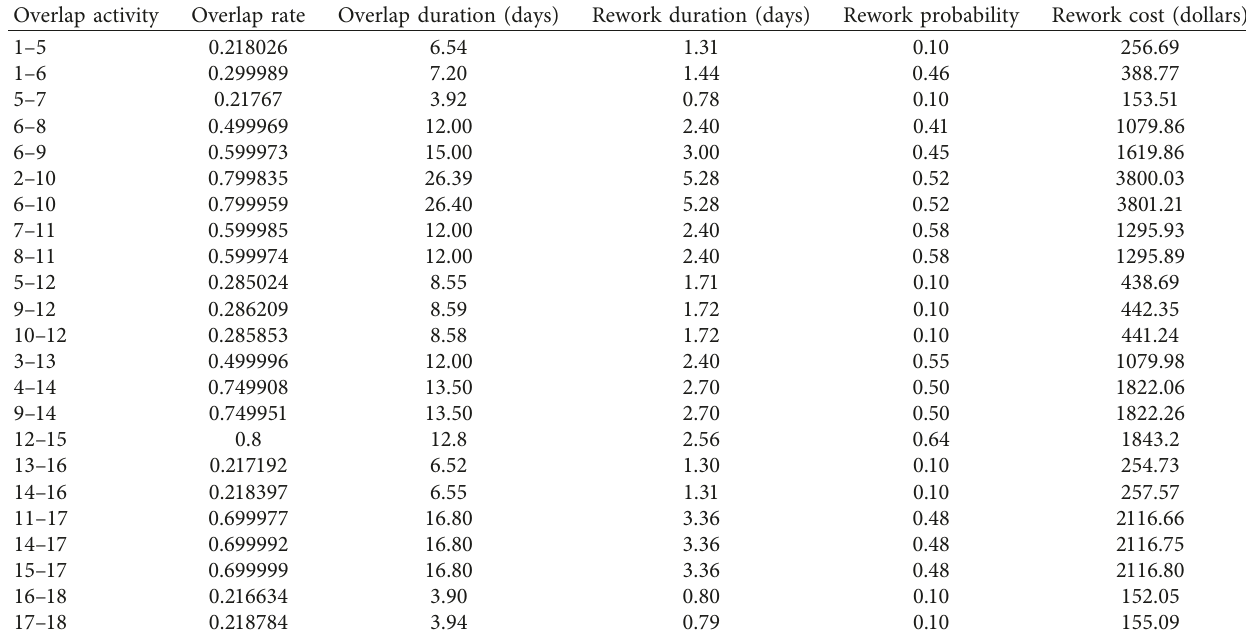
Table 2: The optimal overlapping strategy of the